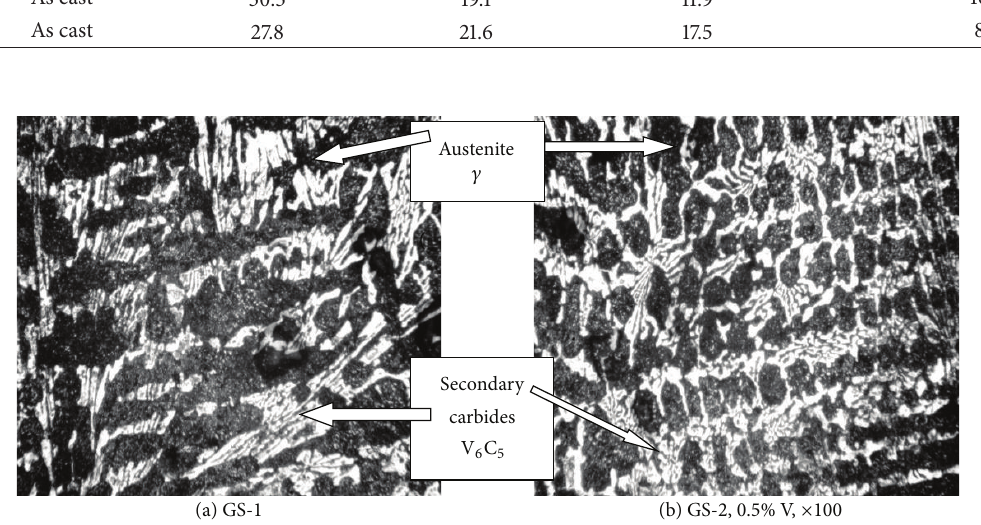
Figure 3: As-cast microstructure of GS-1 and GS-2 experimental steel.